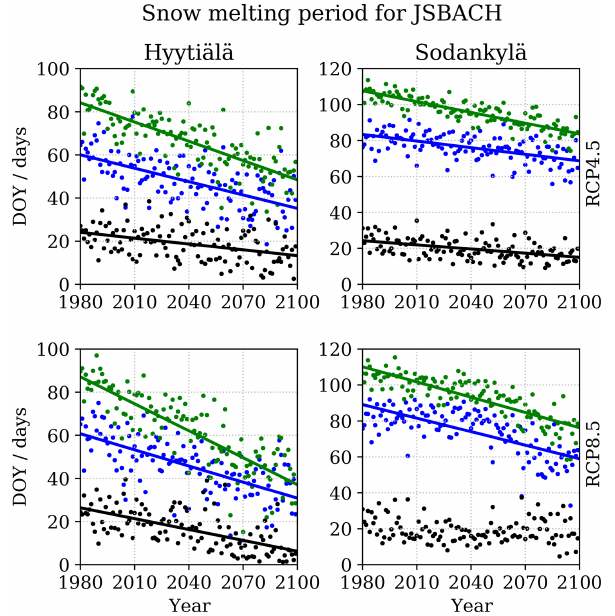
Figure 6. The average snow melting period for the JSBACH model; presented are the average annual values for the start of the snow melting period (blue), the first snow-free day of the year (green), and their difference (black) as well as trend lines (calculated from the shown values) for these variables (when applicable). Table 3. Classification of trends according to the Mann–Kendall test in annual drought days for all simulations.